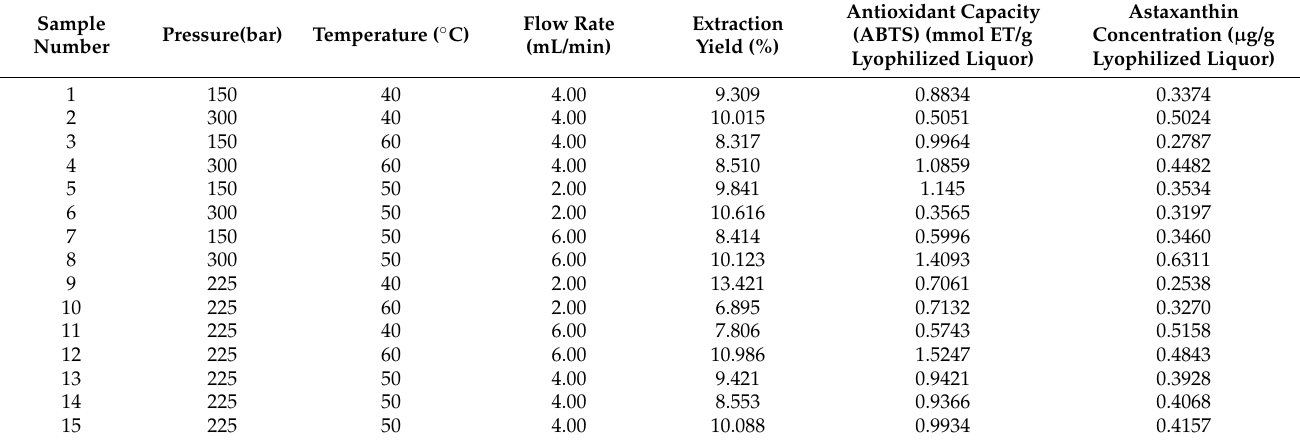
Table 4. Box–Behnken design of factors with codes for astaxanthin supercritical CO 2 extraction from lyophilized liquor. Sample